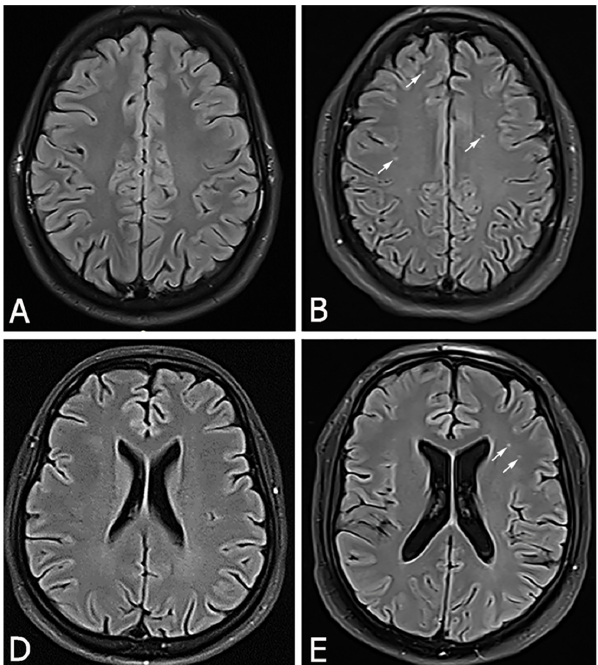
Figure 2. In September 2019.year, our patient had brain MRI ( A , D ) on which there were no patholog- ical lesions ( A , D ). In March 2021.year, now 24-year-old same patient, 61 days after onset of moderate SARS-CoV-2 infection, had brain MRI who showed a hyperintensive lesions located bilaterally frontally subcortically and periventricularly on the FLAIR sequence ( B , E ). After discharge from the hospital, we also performed Transcranial Color Doppler (TCCD) on our patient with a breath holding test (BHT) which indicated decreased breath holding index (BHI) and impaired cerebral vasoreactivity (Table 2), as often occurs in patients after SARS-CoV-2